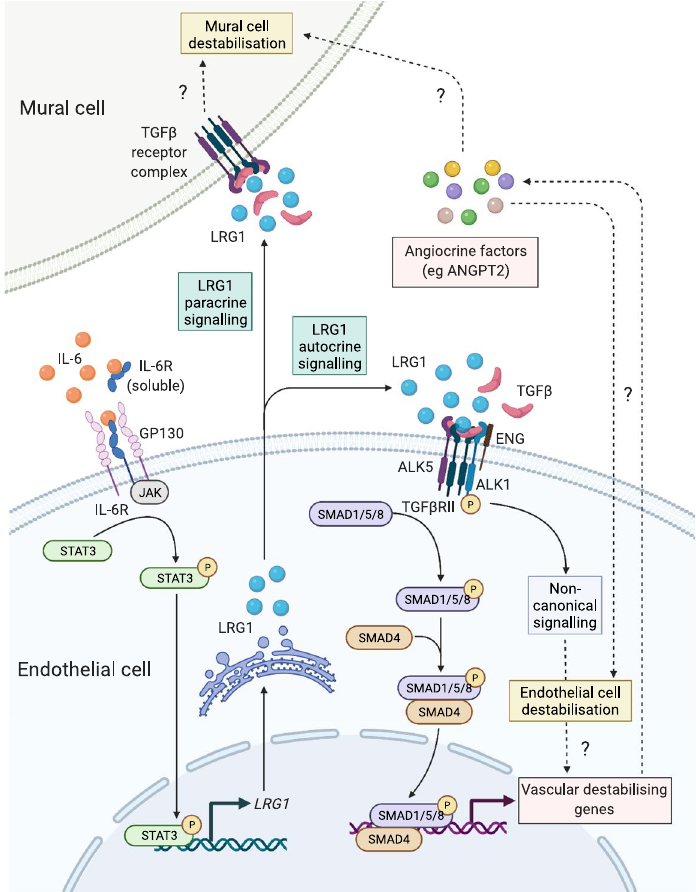
Figure 6. IL-6-dependent induction of LRG1 and proposed downstream angiopathic effector mechanisms. IL-6 induces LRG1 in endothelial cells, but not mural cells. LRG1 may then act in an autocrine loop on endothelial cells through the TGFβ receptor complex to activate canonical and non-canonical signalling that will modify endothelial cell function and induce vascular destabilising genes. In turn, the LRG1-mediated induction of angiocrine factors may result in indirect angiopathic effects on endothelial cells and mural cells. Alternatively, LRG1 may signal in a paracrine fashion directly on mural cells to drive destabilisation. Dashed lines with question marks represent speculative pathways. Created with